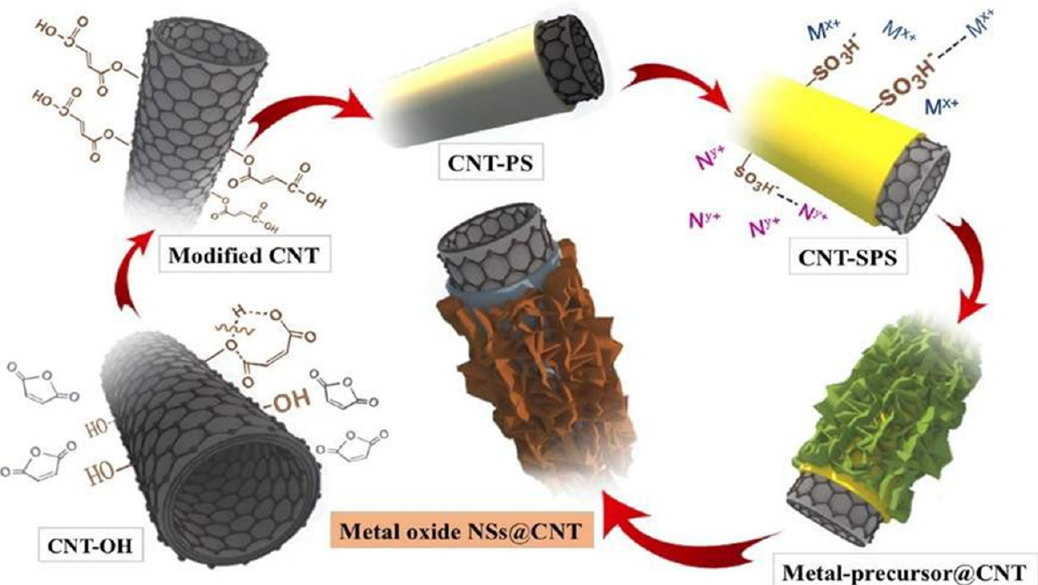
Figure 14. A synthetic approach for TMO@CNT hybrid materials, involving pre-coating CNT with sulfonated polystyrene, depicted schematically. Reproduced with permission from [89].